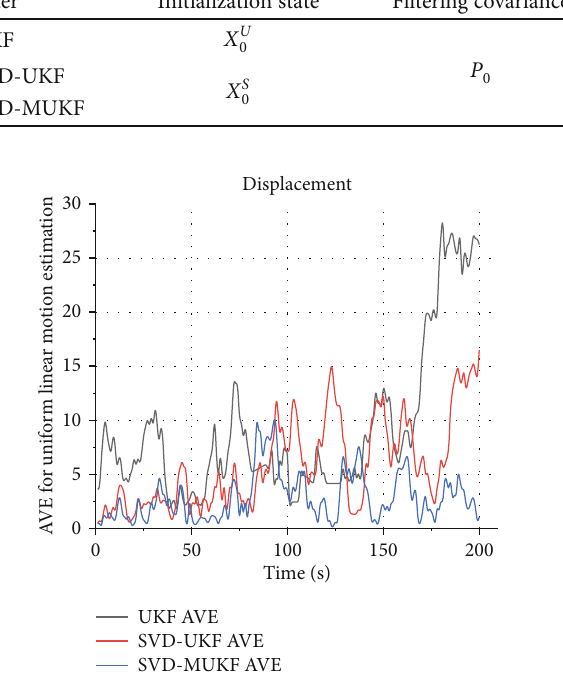
Figure 6: AVE for uniform linear motion estimation